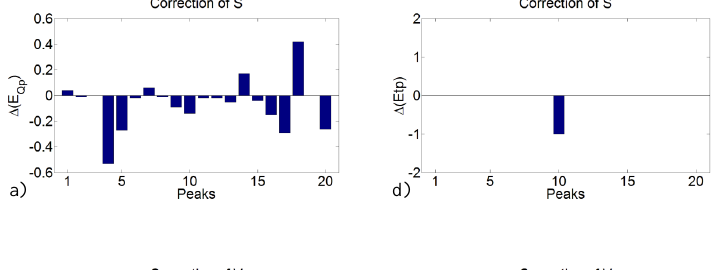
Figure 4. Histograms that represent the correction efficiency on the estimation of the peak